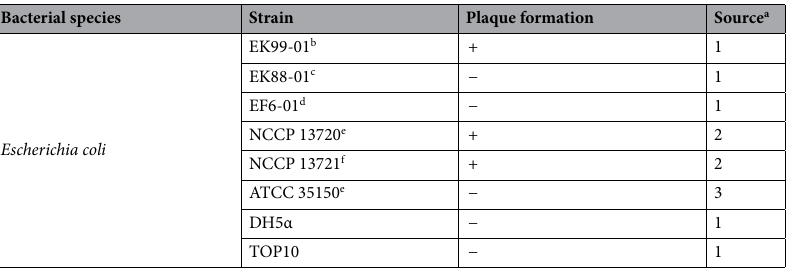
Table 1. Host range of bacteriophage EK99P-1 against E. coli strain. a 1: laboratory collection; 2: obtained from the National Culture Collection for Pathogens; 3: purchased from the American Type Culture Collection. b E. coli with the F5 (K99) antigen. c E. coli with the F4 (K88) antigen. d E. coli with the F6 antigen. e Enterohemorrhagic E. coli (EHEC) and E. coli O157:H7. f Enteroaggregative E. coli (EAEC) and enterohemorrhagic E. coli